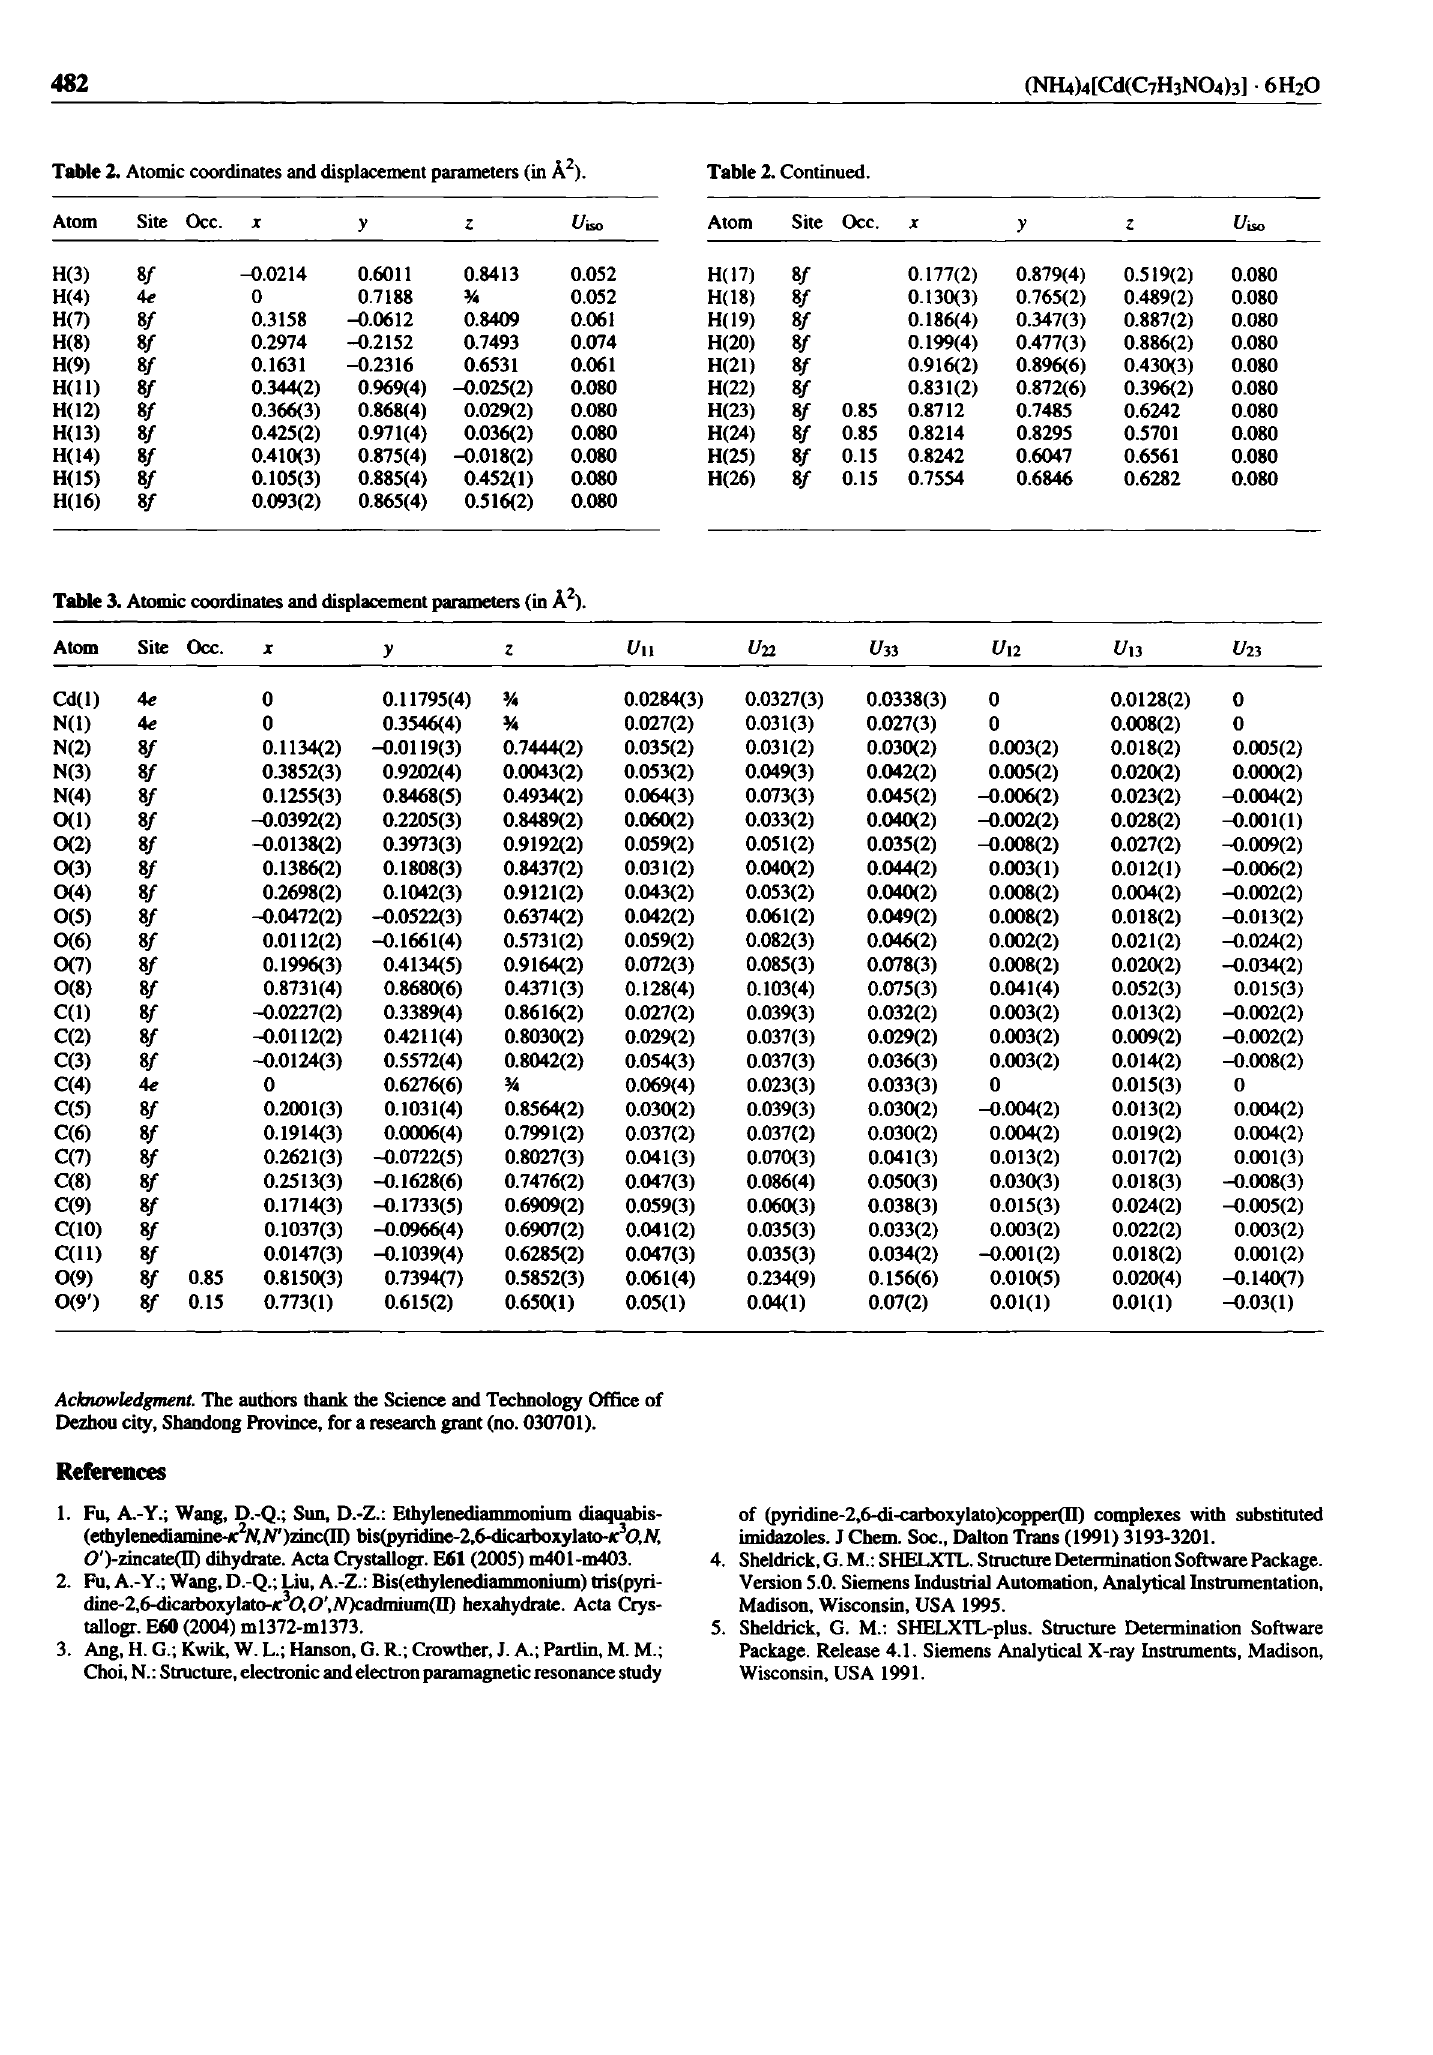
Table 2. Atomic coordinates and displacement parameters (in A 2 ).